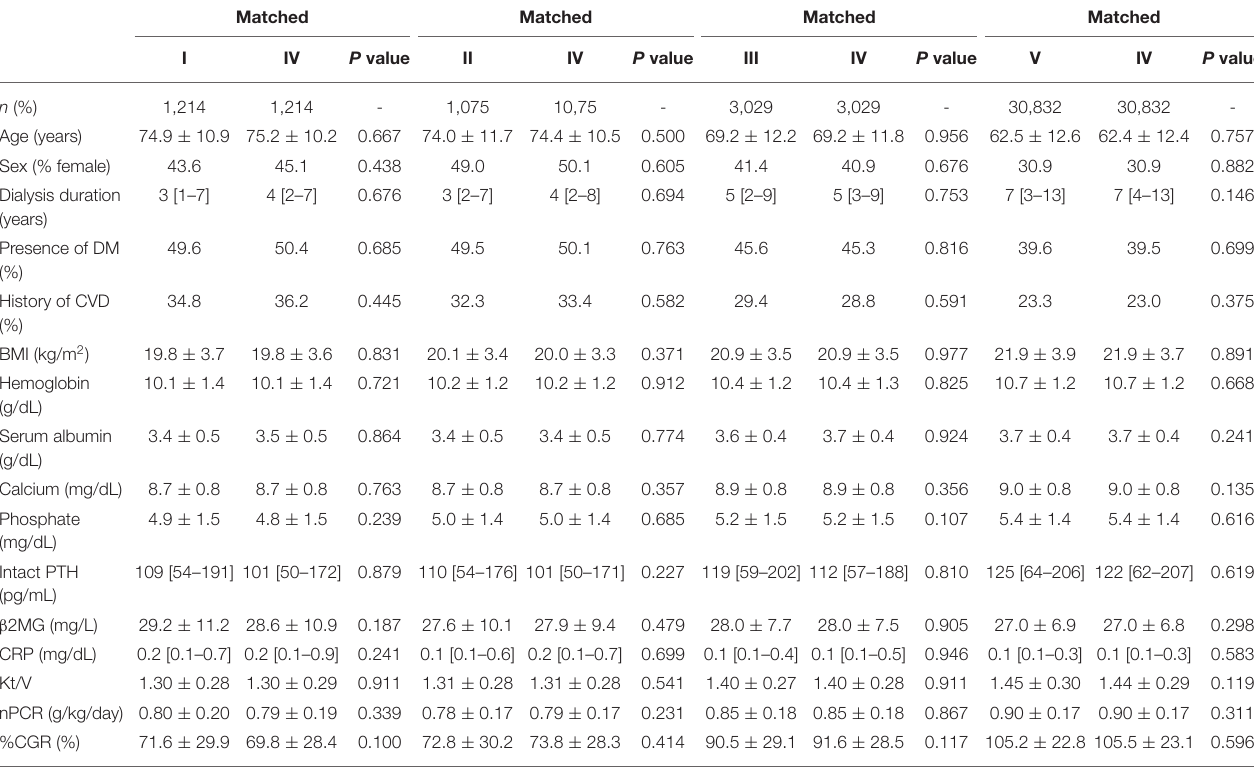
TABLE 5 | Baseline characteristics after propensity score matching between type IV dialyzers (reference) and other dialyzer types. Matched Matched Matched Matched I IV P value II IV P value III IV P value V IV P